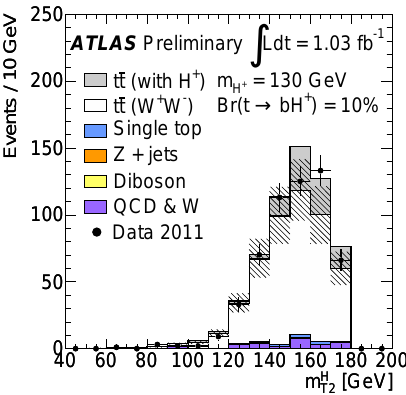
< < 60 GeV. Fig. 6. m H 0 . 6, m W l T −